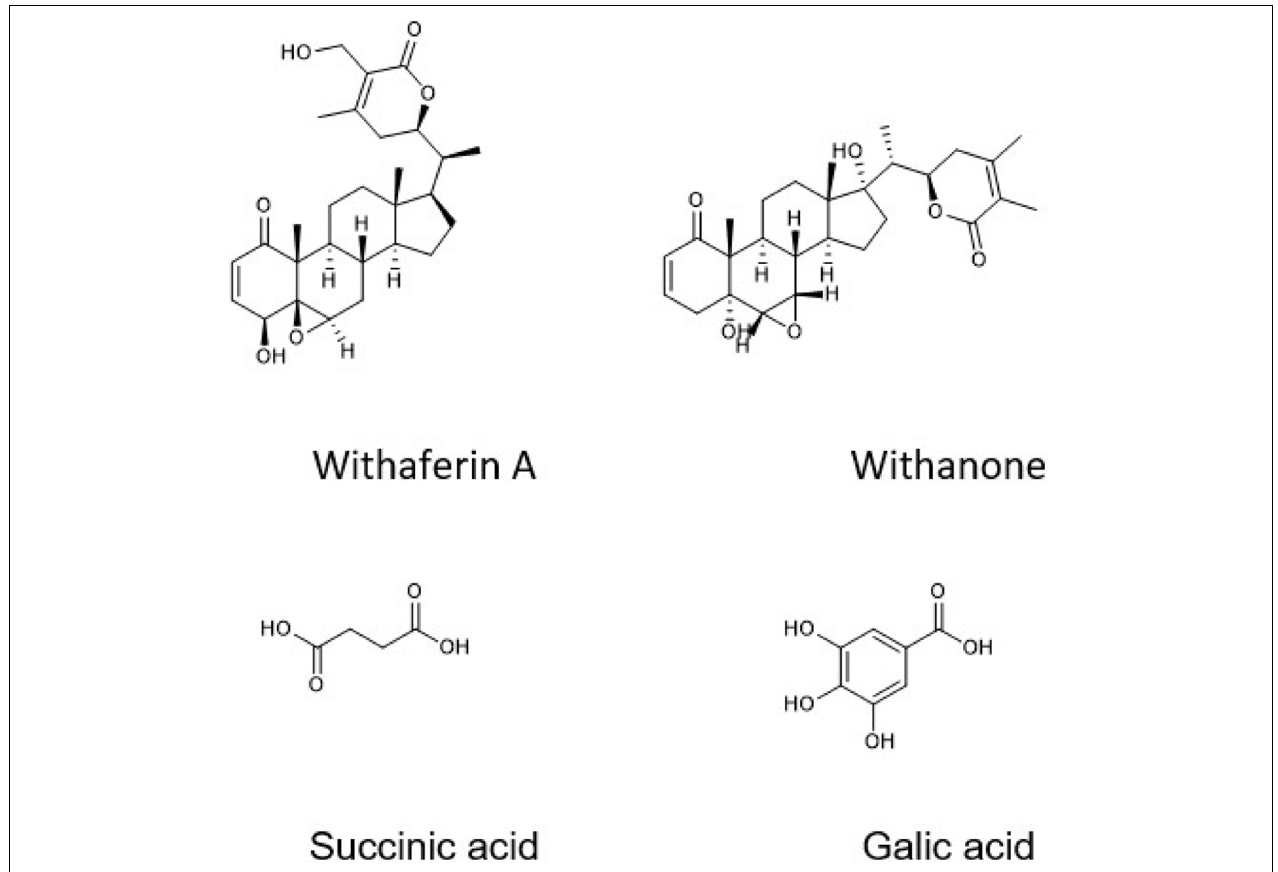
FIGURE 3 | Chemical structure for selected compounds in the water extract of